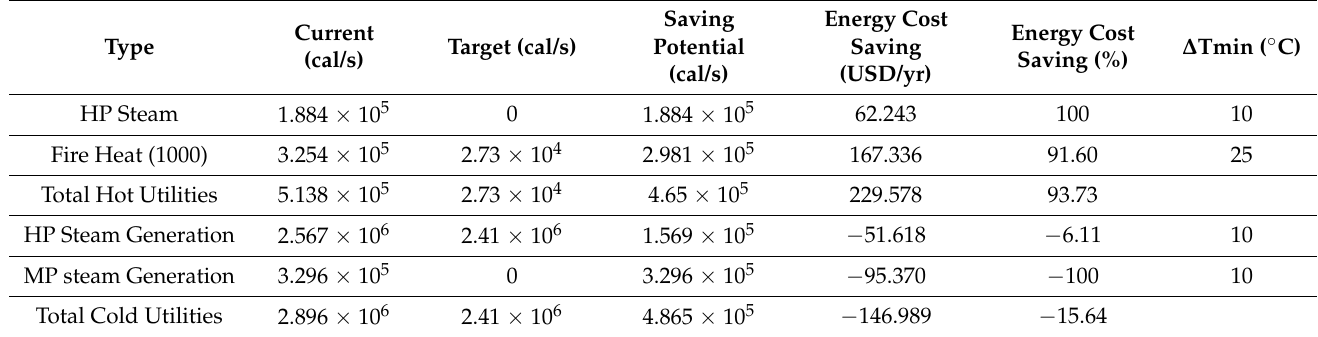
Table 5. Utilities cost and energy saving by pinch analysis with the help of Aspen Plus.